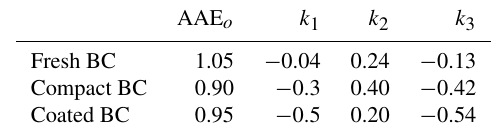
Table 2. Fitted coefficients to show the sensitivities of BC properties on AAE values. Two significant figures are kept for all coefficients.